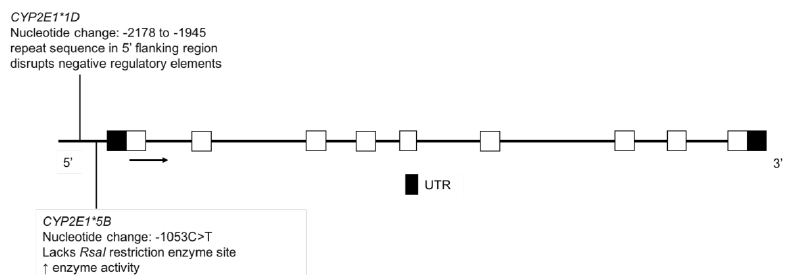
Figure 10. The human CYP2E1 gene and the variants identified in the FN and Amerindian populations. Open boxes represent exons, lines represent introns and shaded boxes represent UTR. Table 10. Comparison of CYP2E1 allele frequencies Indigenous North American populations to global populations from the 1000 Genomes Project [20]. N represents the number of alleles. Global populations are abbreviated as follows: African Ancestry in Southwest US (ASW); Utah residents with Northern and Western European ancestry (CEU); Han Chinese in Beijing, China (CHB); Mexican Ancestry in Los Angeles, California (MXL).